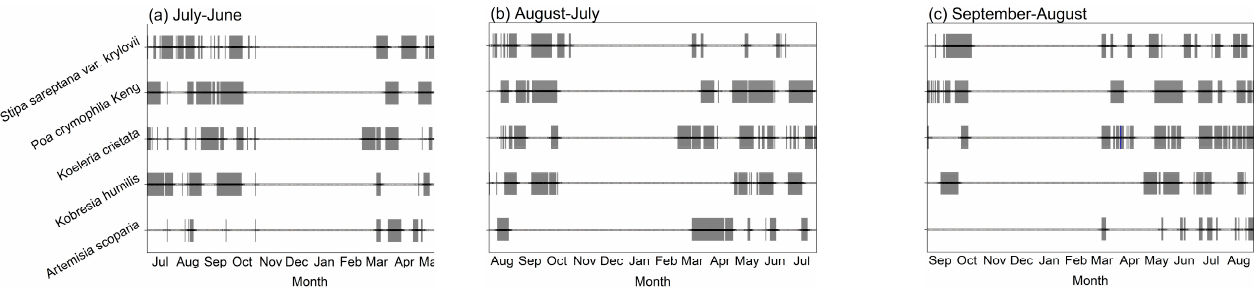
Figure 7. Results of Partial Least Squares (PLS) regression correlating biomass with daily effective precipitation during ( a ) July–June, ( b ) August–July and ( c ) September–August for different species. Gray bars show significant positive relationships between aboveground biomass and precipitation.